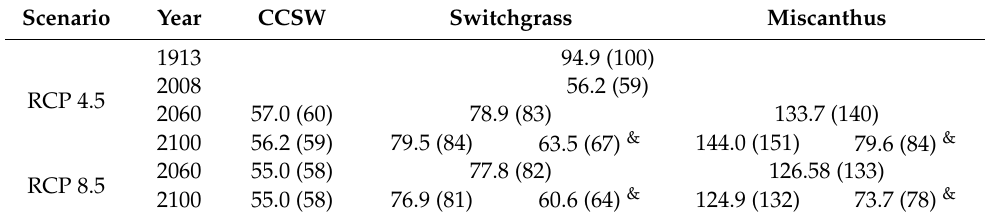
Figure 2. Soil organic carbon (SOC) dynamics over 1913–2100 in corn-corn -soybean-winter wheat ( a ), switchgrass ( b ) and miscanthus ( c ) cropping systems, predicted by DayCent in 20 cm soil layer for two representative concentration pathways: RCP 4.5 and 8.5. CCSW = corn–corn–soybean–winter wheat; SG = switchgrass; MIS = miscanthus. Table 4. Soil organic carbon (SOC) stock (Mg ha − 1 ) over 21st century under corn–corn–soybean–winter wheat # (CCSW), switchgrass and